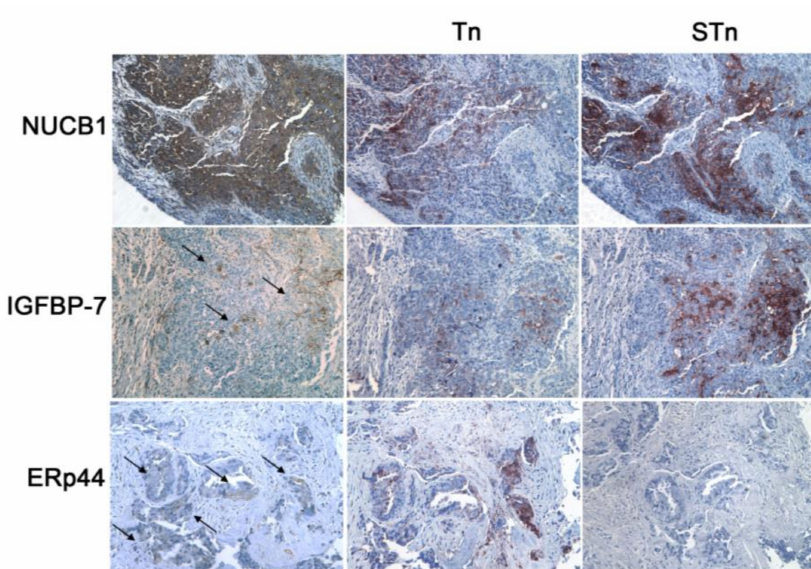
Figure 4. Tissue staining patterns of tumor MGL binders. Expression of nucleobindin-1 (NUCB1), insulin-like growth factor binding protein 7 (IGFBP-7), and endoplasmic reticulum resident protein 44